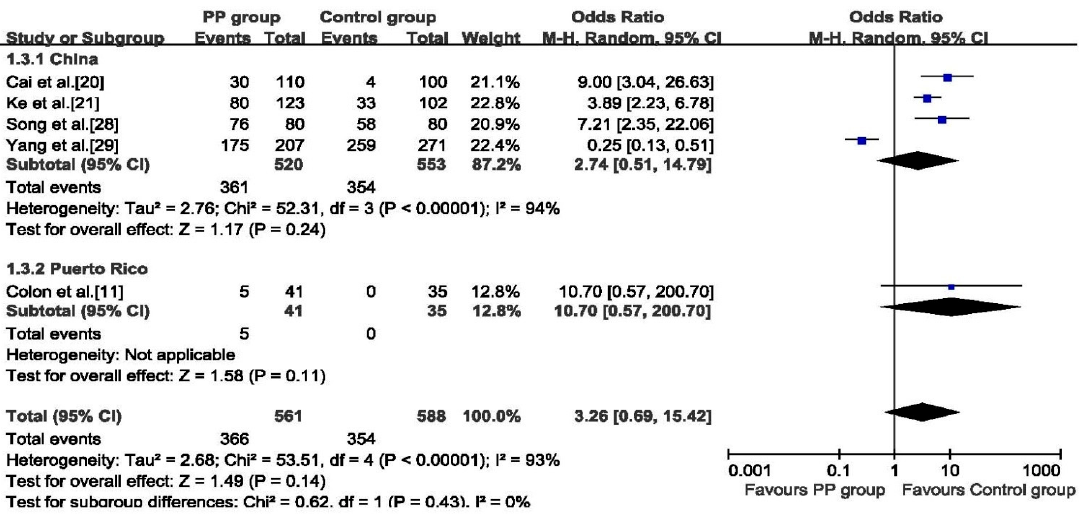
Figure 3. Forest plot for the association between serum DBP and PP.